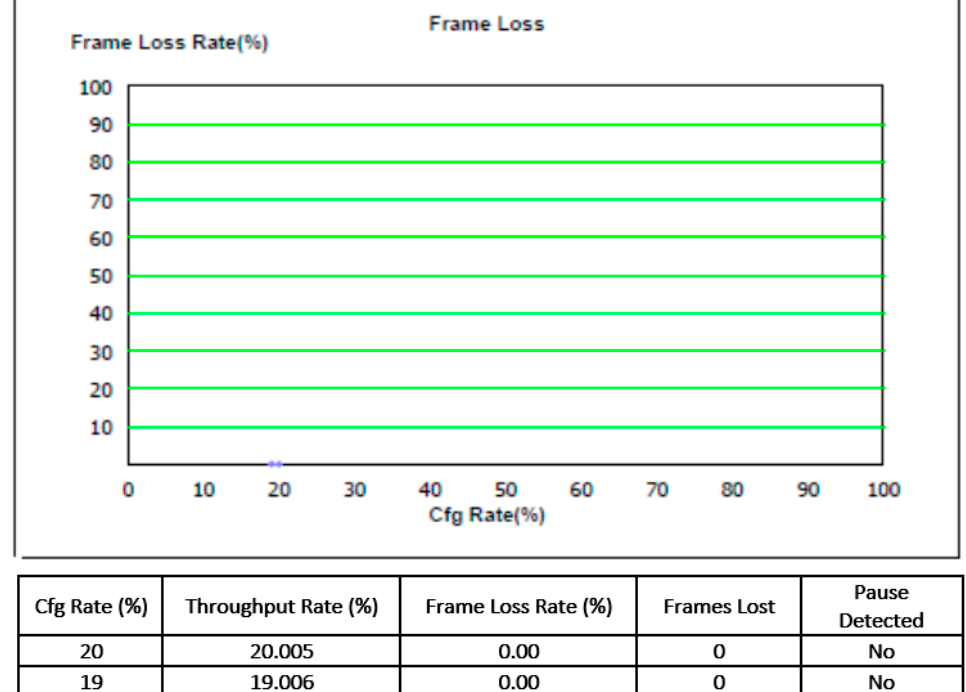
Figure 20. Packet loss (for packet size of 1500 Bytes).